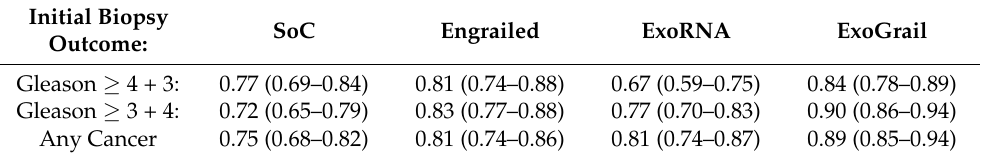
Table 3. Area under the receiver operator curve (AUC) of all trained models for detecting outcomes of an initial biopsy for varying clinically significant thresholds. Numbers within brackets detail 95% confidence intervals of the AUC, calculated from 1000 stratified bootstrap resamples. Input variables for each model are detailed in Table